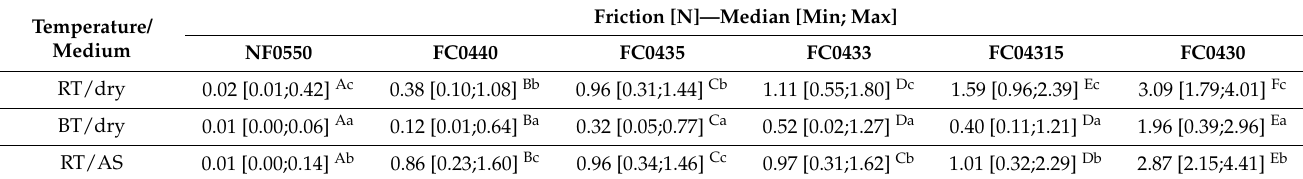
Table 1. Median friction between the six types of coverings and wires in different environments.